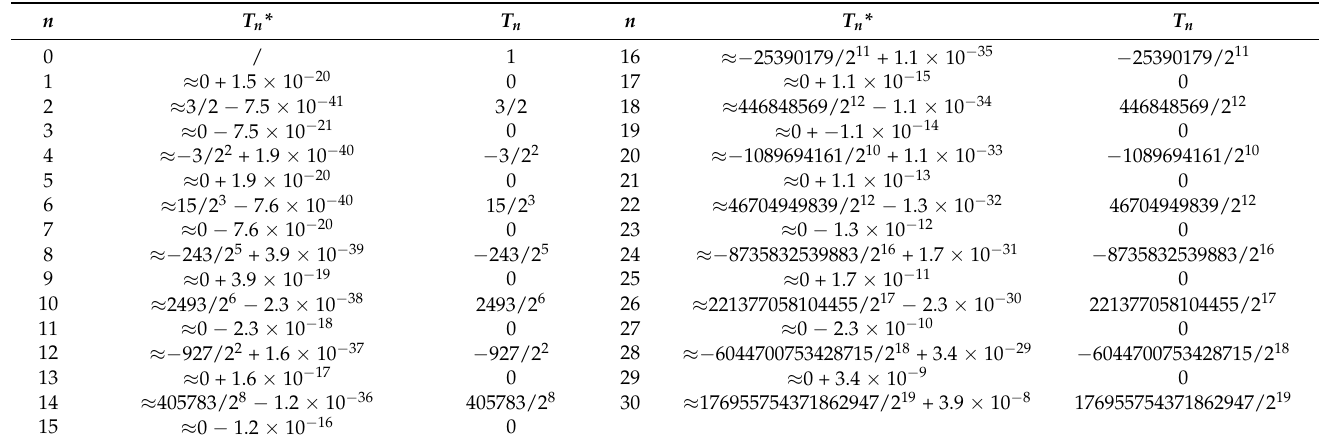
Table A2. The first 31 coefficients T n in Equation